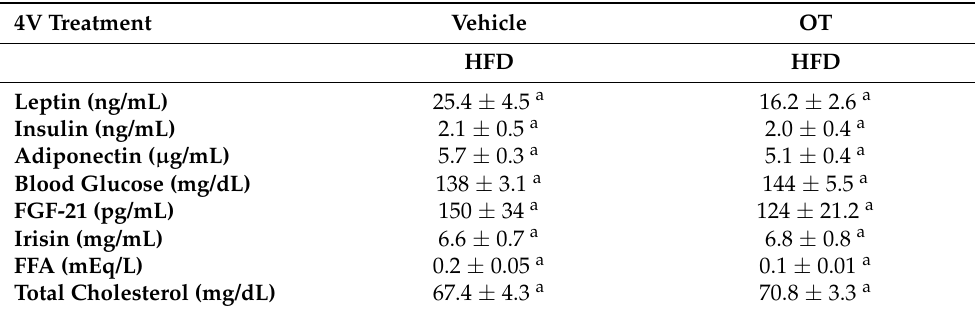
Table 1. Plasma measurements following 4V infusions of OT or vehicle in male HFD-fed CD ® IGS